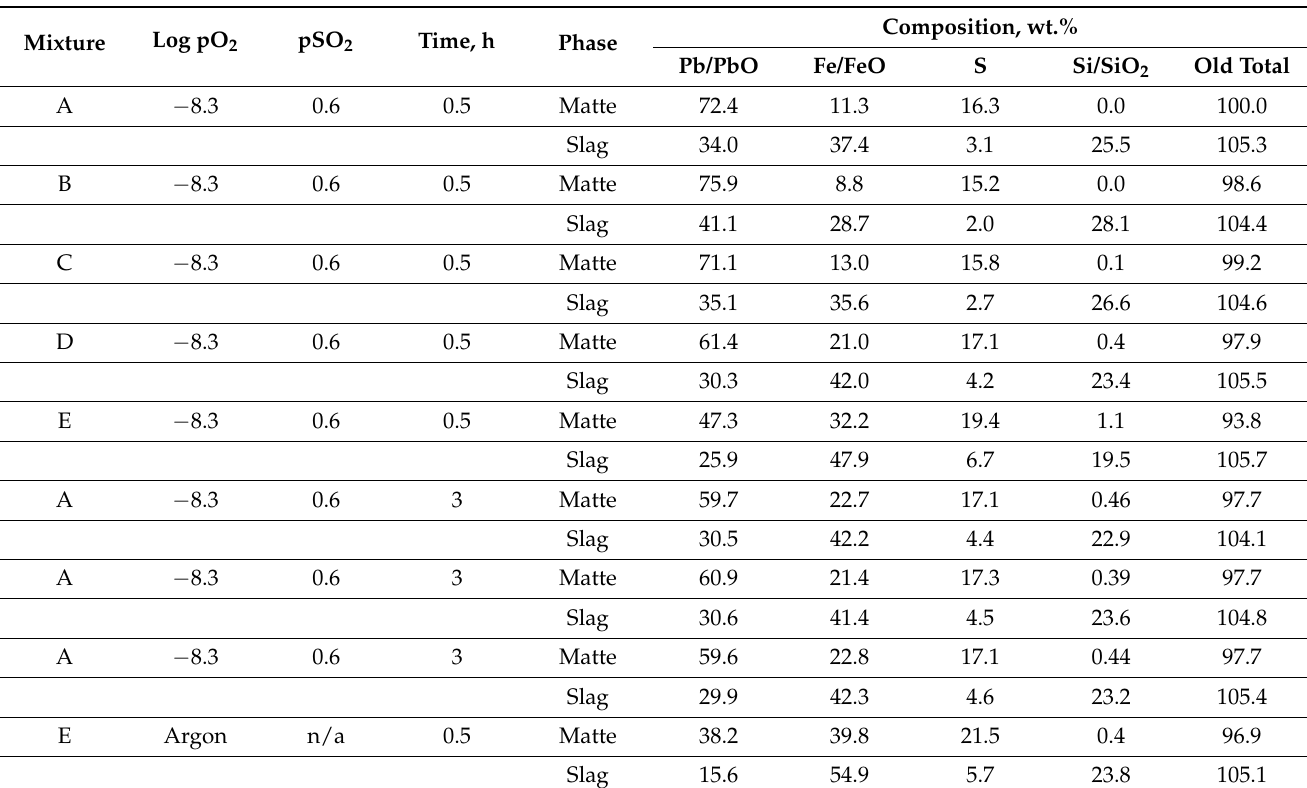
Table 5. Compositions of the phases obtained in the semi-open slag–matte–metal–tridymite equilib- rium experiments in the Pb-Fe-O-Si-S